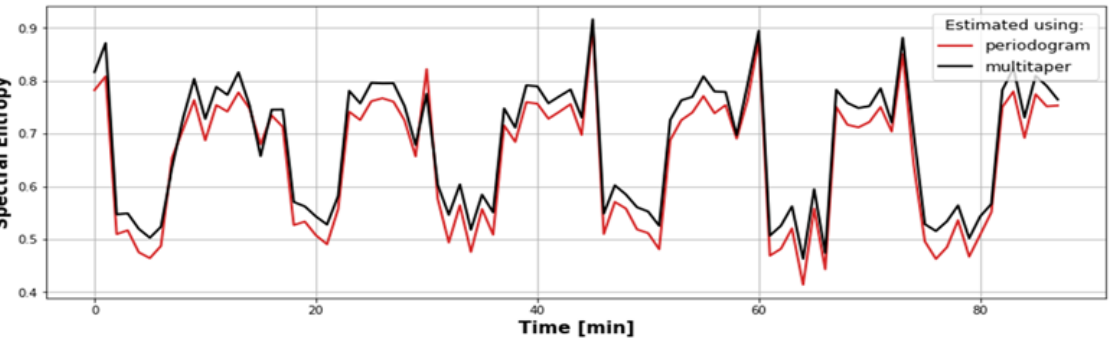
Figure 5. Comparison of spectral entropy estimated with the use of a periodogram and multitaper.